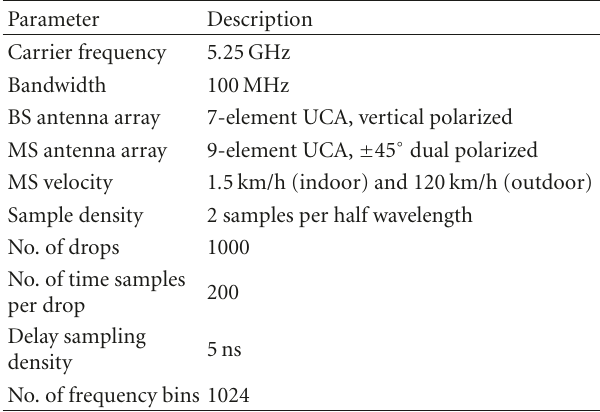
Table 4: Assumptions of channel